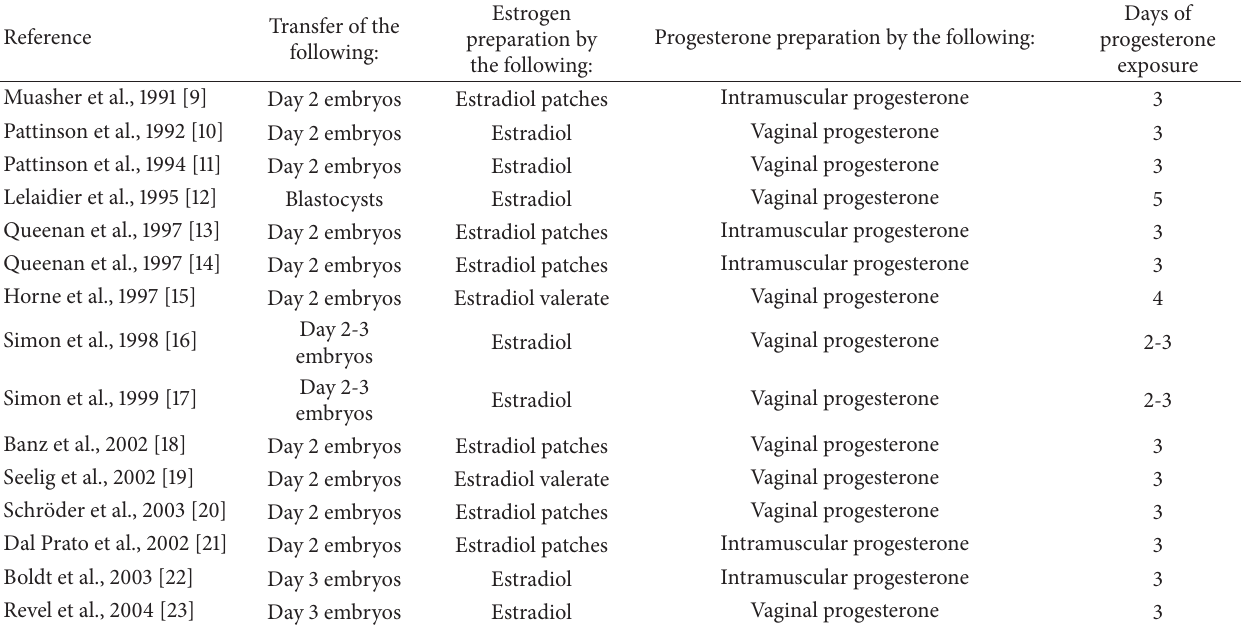
Table2:Somestudiesdealingwithestrogen/progesteronesupplementationtoprepareendometriumbeforetransferofcryopreserved-thawed